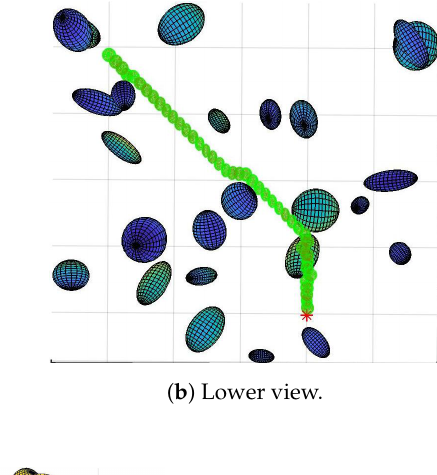
Figure 11. Path of map 3 generated with TLBO. The path represented by the green ellipsoids, are sufficiently smooth for the UAV.